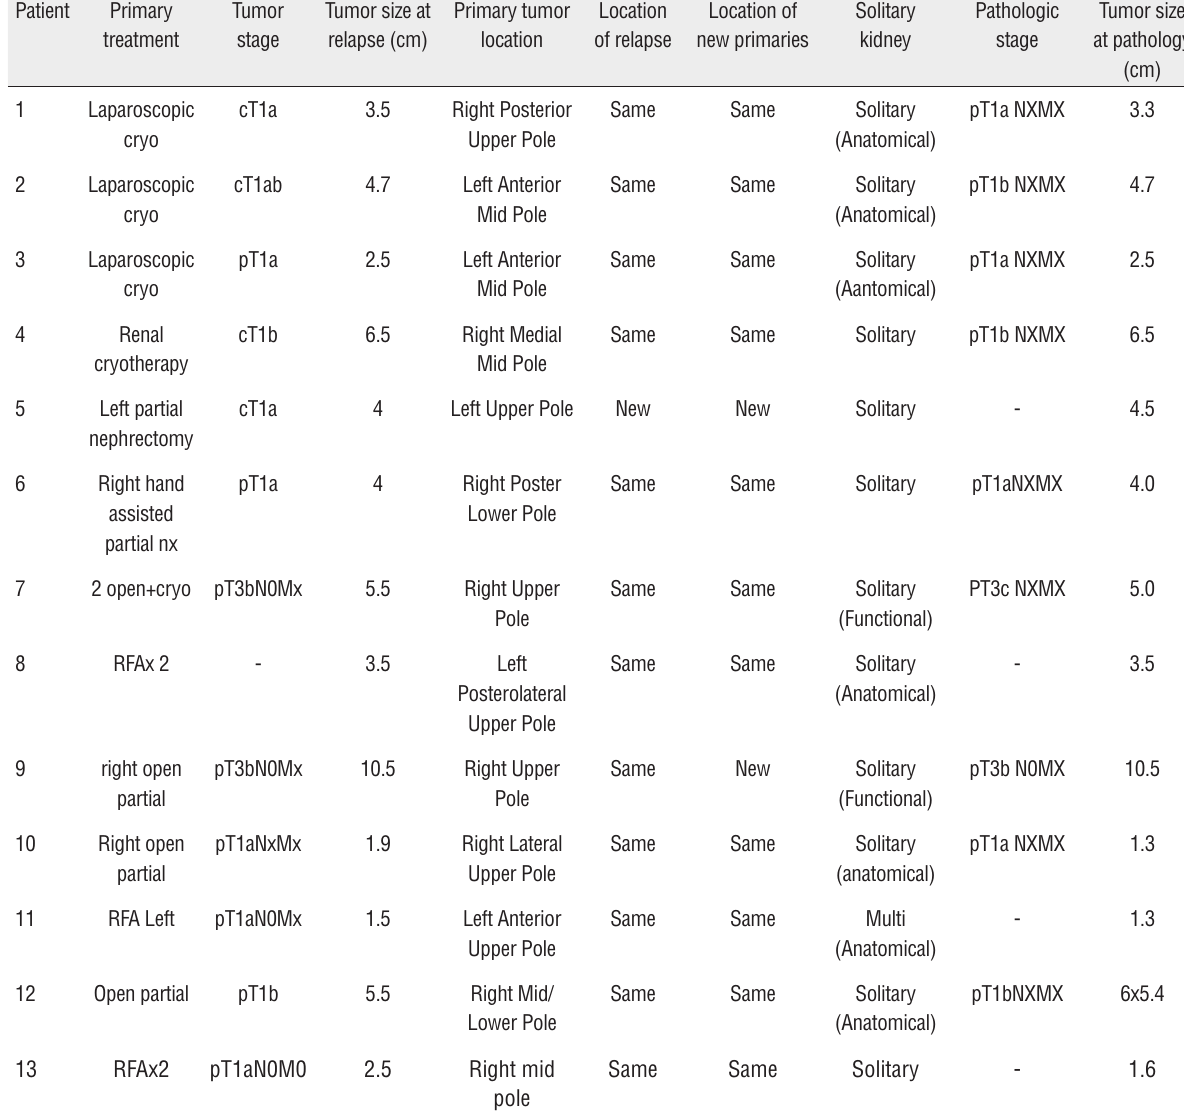
Table 3 - Details of primary treatment, tumor stage, size of relapse, solitary kidney and pathologic stage for individual patients.